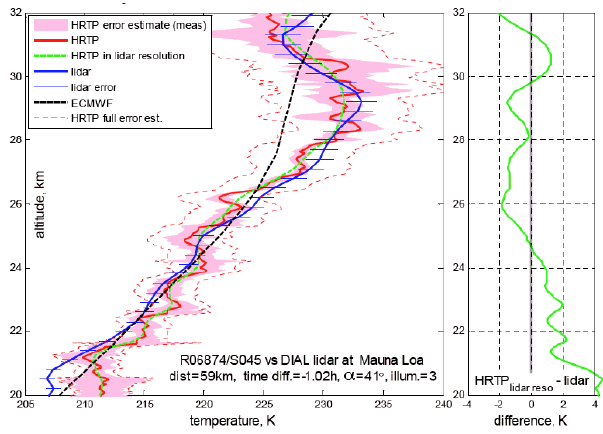
Fig. 56: A sample HRTP temperature profile (in red) obtained from two-color scintillation data. The uncertainty (in pink) distinguishes contribution from random errors (colored area) and total error including initialization bias (dashed). From Dalaudier et al. (2006).